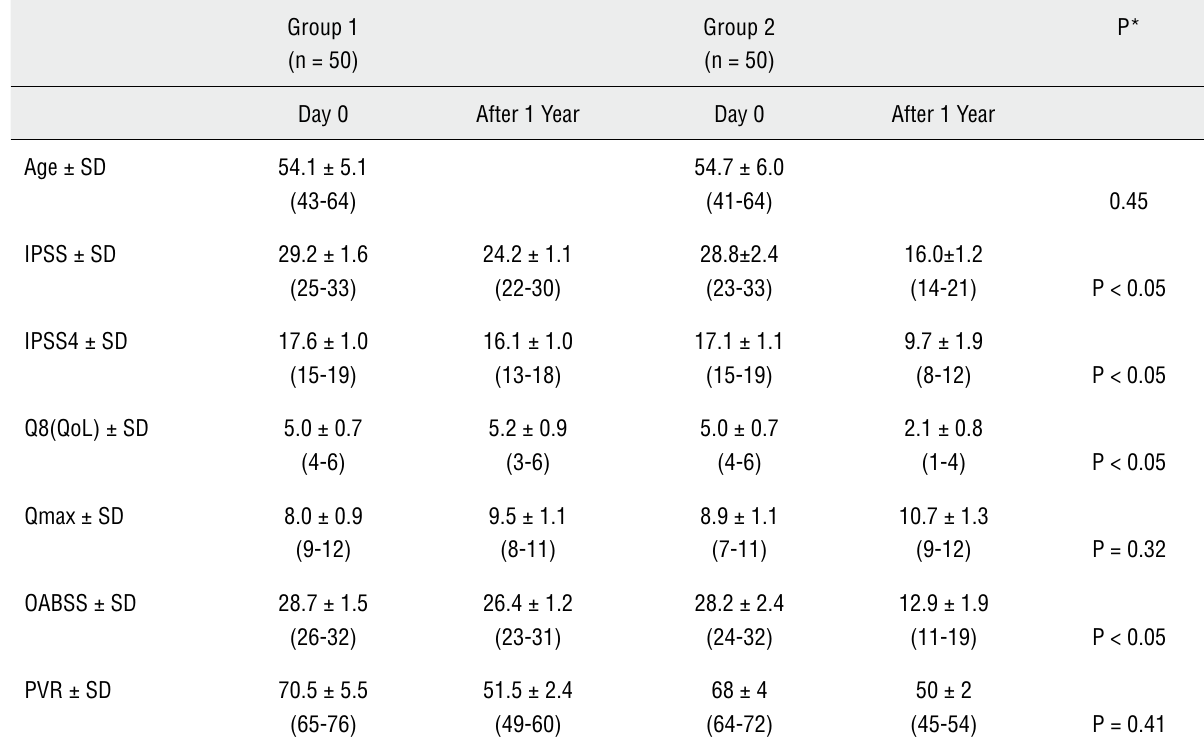
Table 1 - Age and clinical characteristics of the